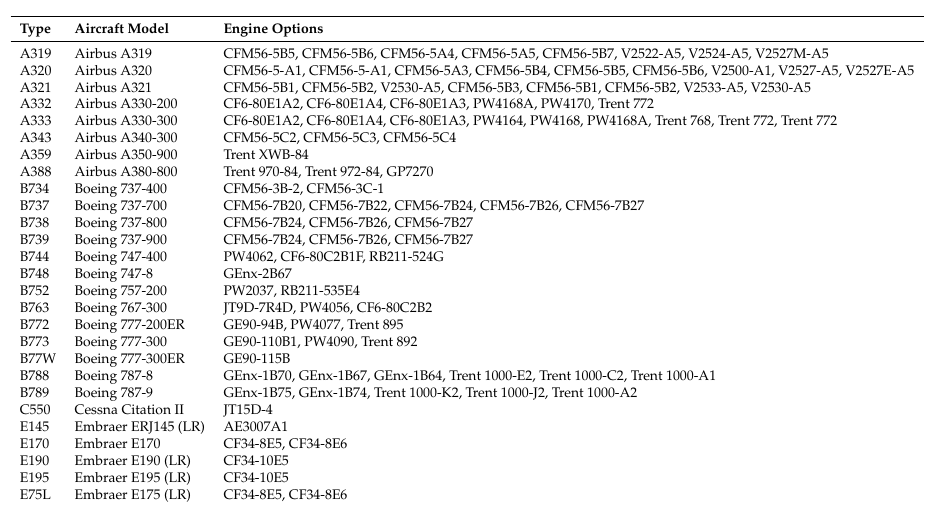
Table A1. Current available aircraft types in